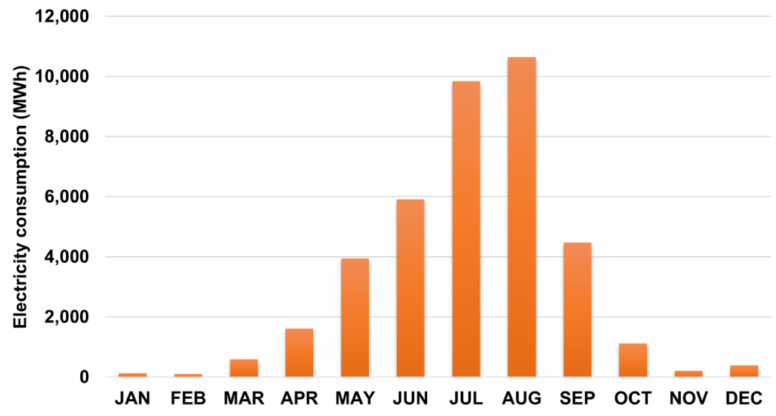
Figure 3. Annual electricity demand.